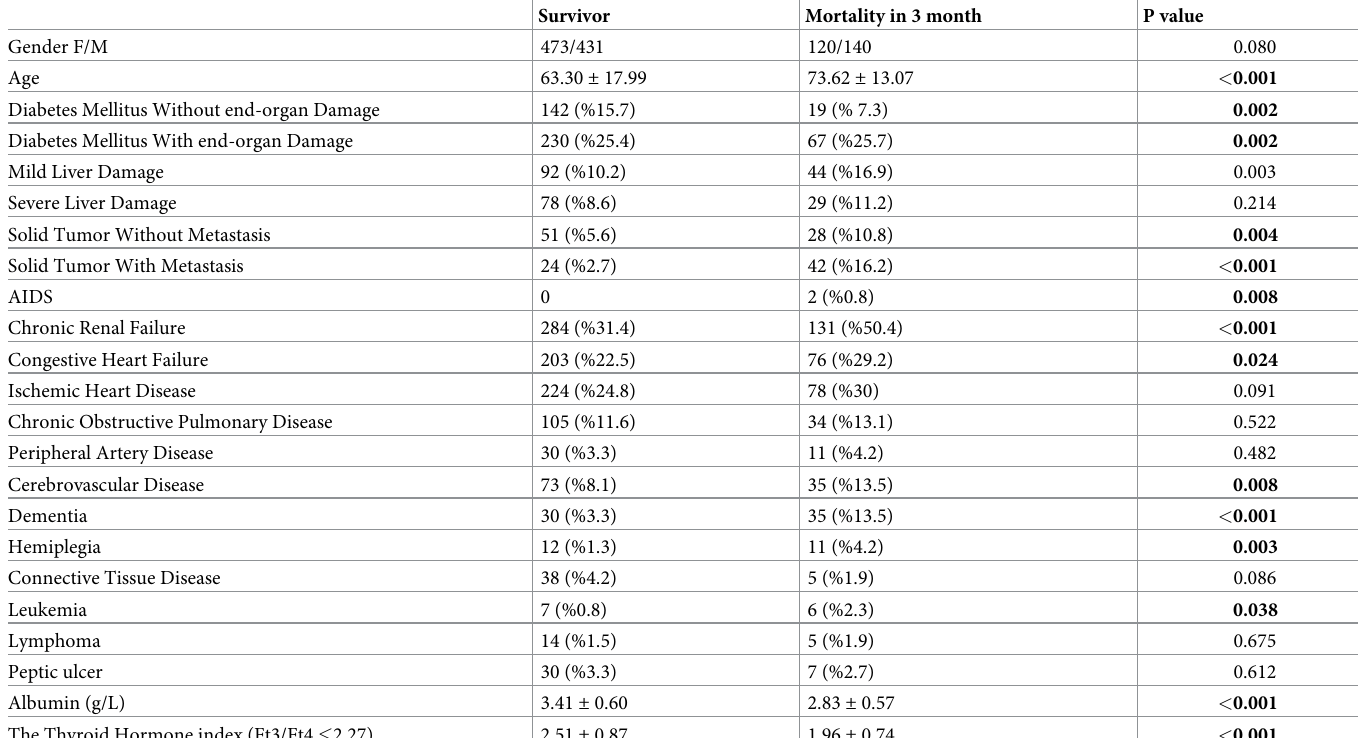
Table 1. Baseline characteristics of patients in 3 month